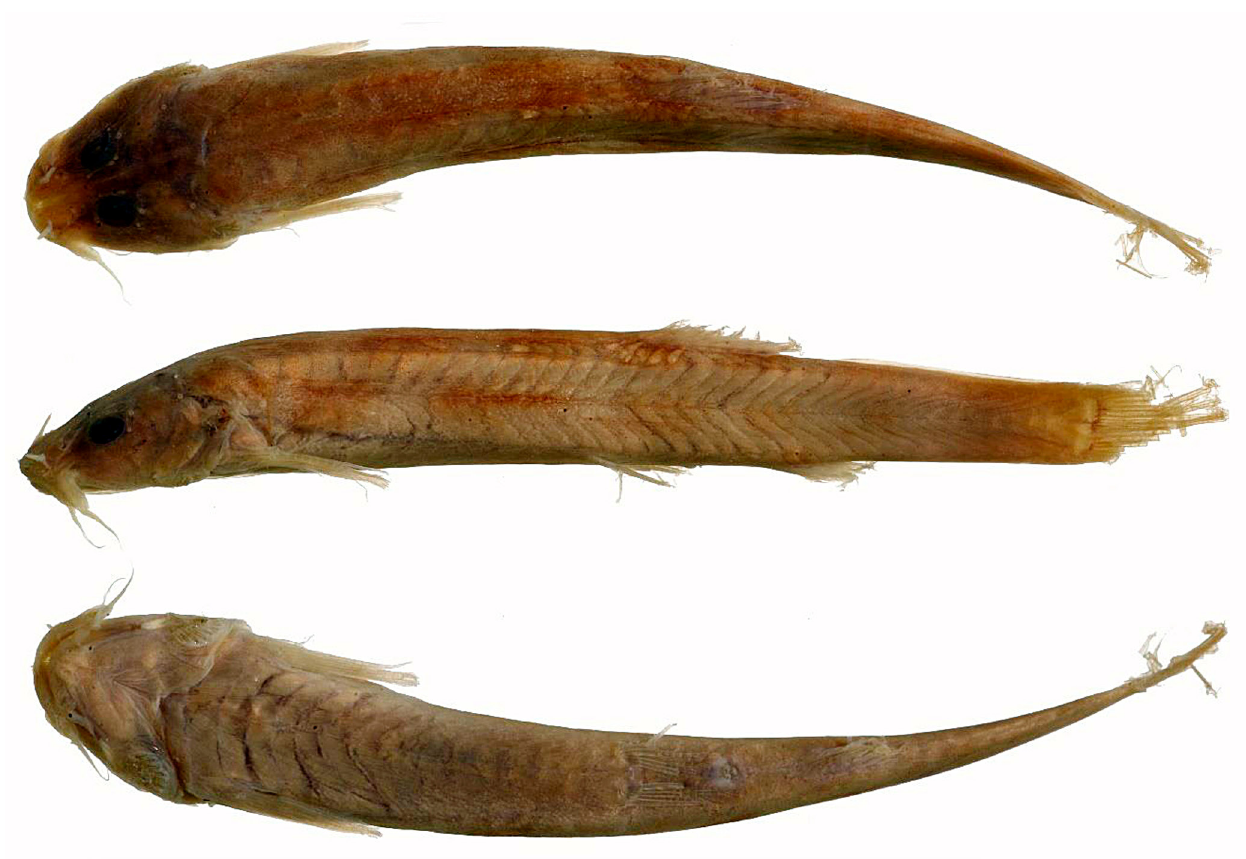
FIGURE 16 | Scleronema minutum , lectotype of Trichomycterus minutus (BMNH 1891.3.16.84; 32.4 mm SL), Brazil, Rio Grande do Sul, São Lourenço do Sul, stream tributary to laguna dos Patos. Photograph taken by Sandra